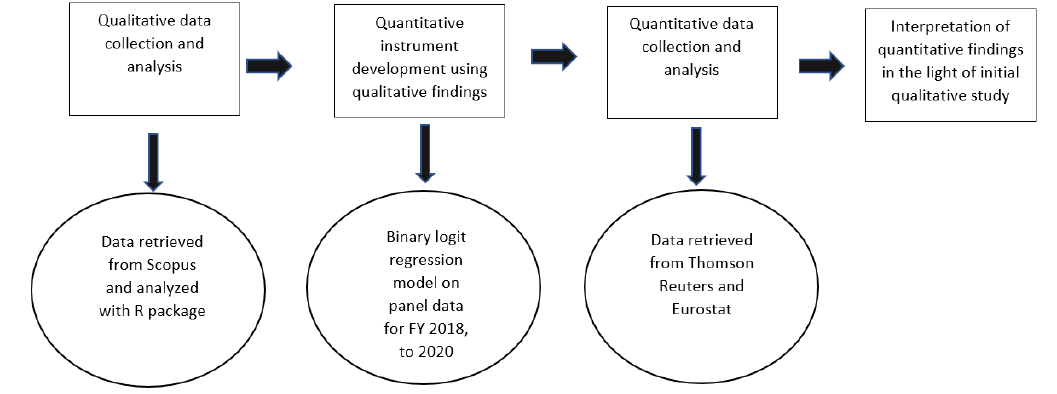
Figure 1. Mixed ‐ methods research design. Source: Own elaboration.